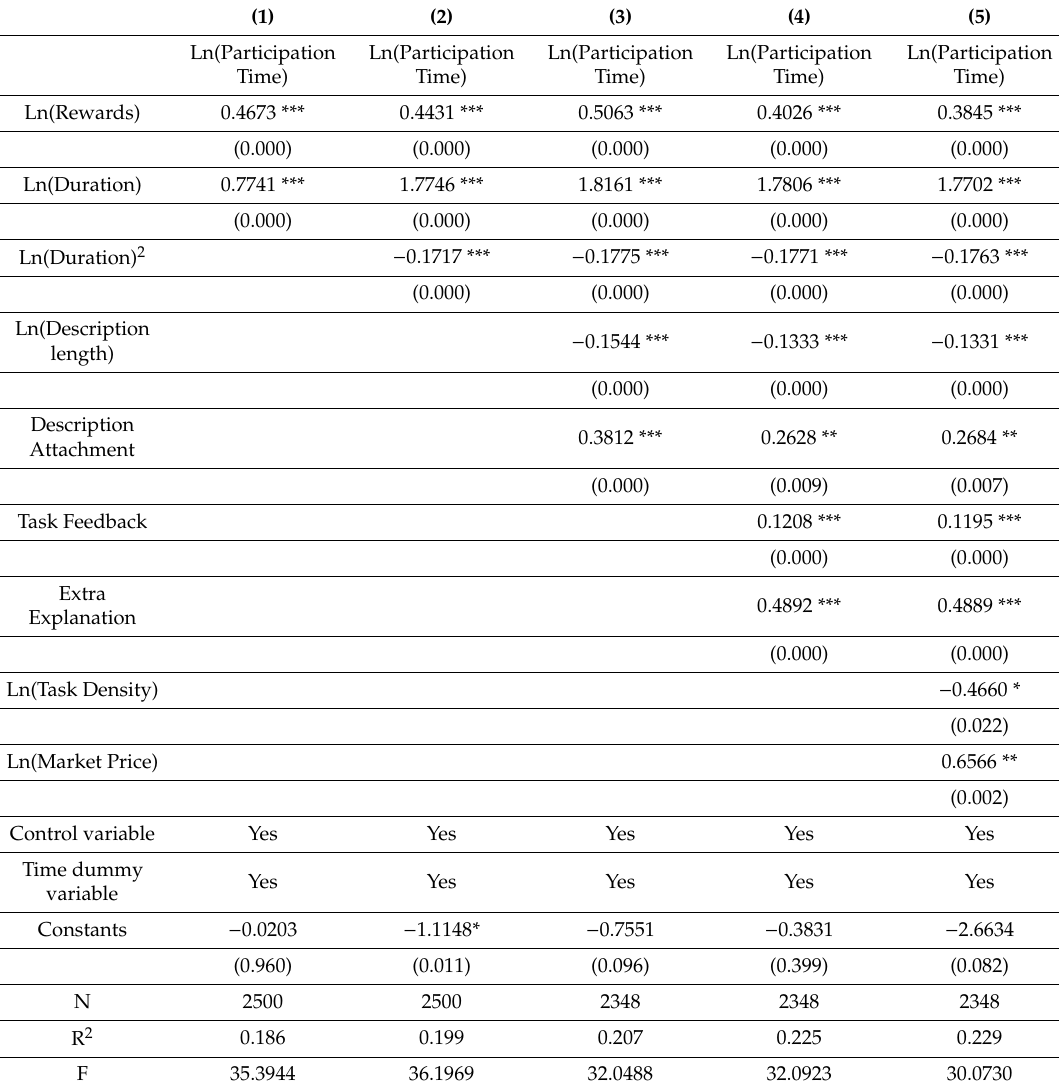
Table 4. Regression